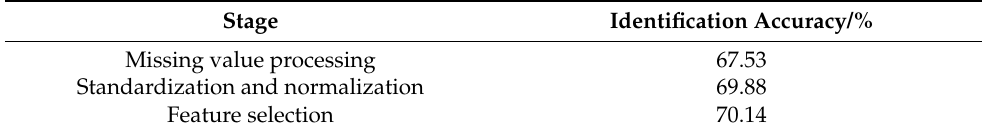
Table 11. Identification effects in different verification